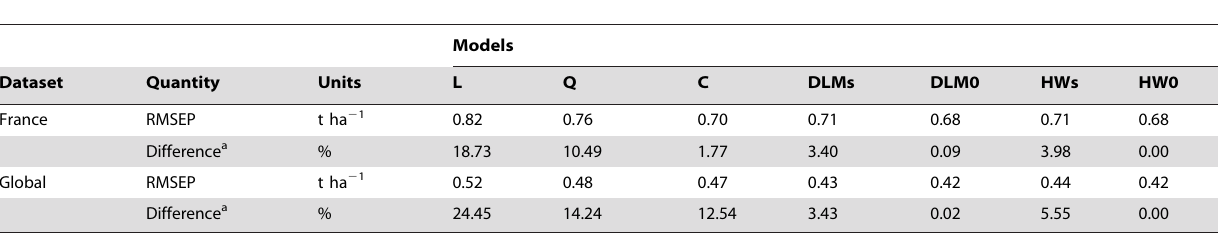
Table 2. Root mean square error of one-year ahead predictions (RMSEP) obtained with two different datasets for several statistical models: linear regression (L), quadratic regression (Q), cubic regression (C), dynamic linear models with and without trend (DLMs, DLM0), and Holt-Winters with and without trend (HWs,